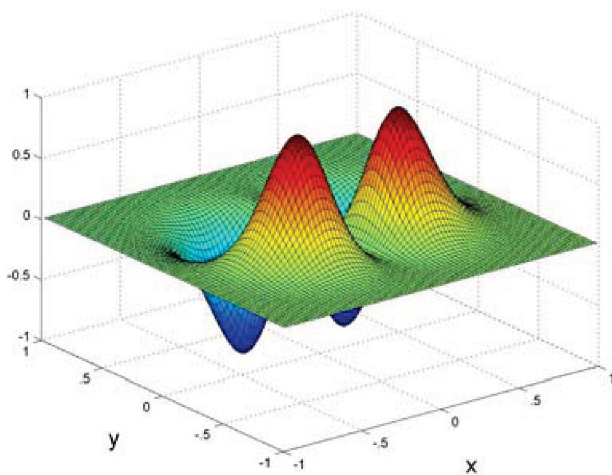
FIG. 5. (Color) A reconstruction of the theoretical object using the Laguerre-Gaussian representation with two profiles. The error between this reconstructed object and the theoretical object is 3.3%.